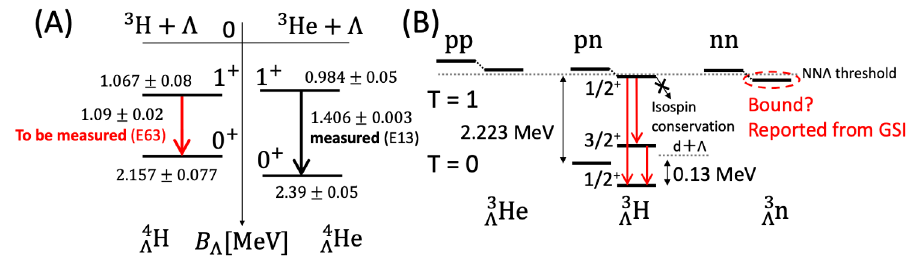
Figure 1. (A) Level schemes of γ -ray transitions of 4 Λ H and 4 Λ He. The Λ binding energy ( B Λ ) of + ) was measured in emulsion experiments [1] and that of 4 4 Λ He (0 [2, 3]. (B) Level schemes of 3 Λ He, 3 Λ H, and 3 Λ n and possible γ -ray transitions in 3 Λ